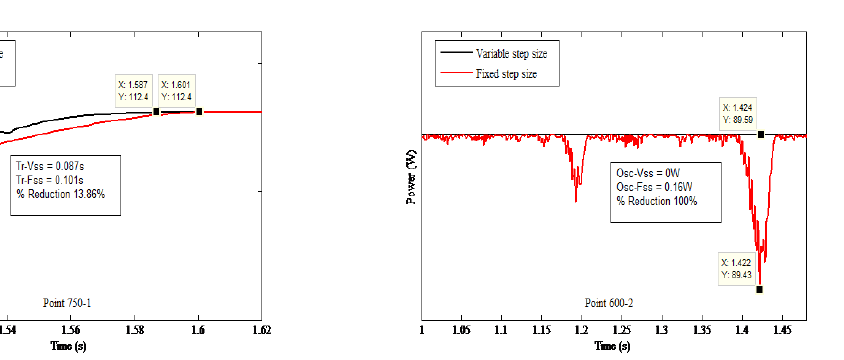
Fig. 9: Output power: Zoom in Point 750-1.